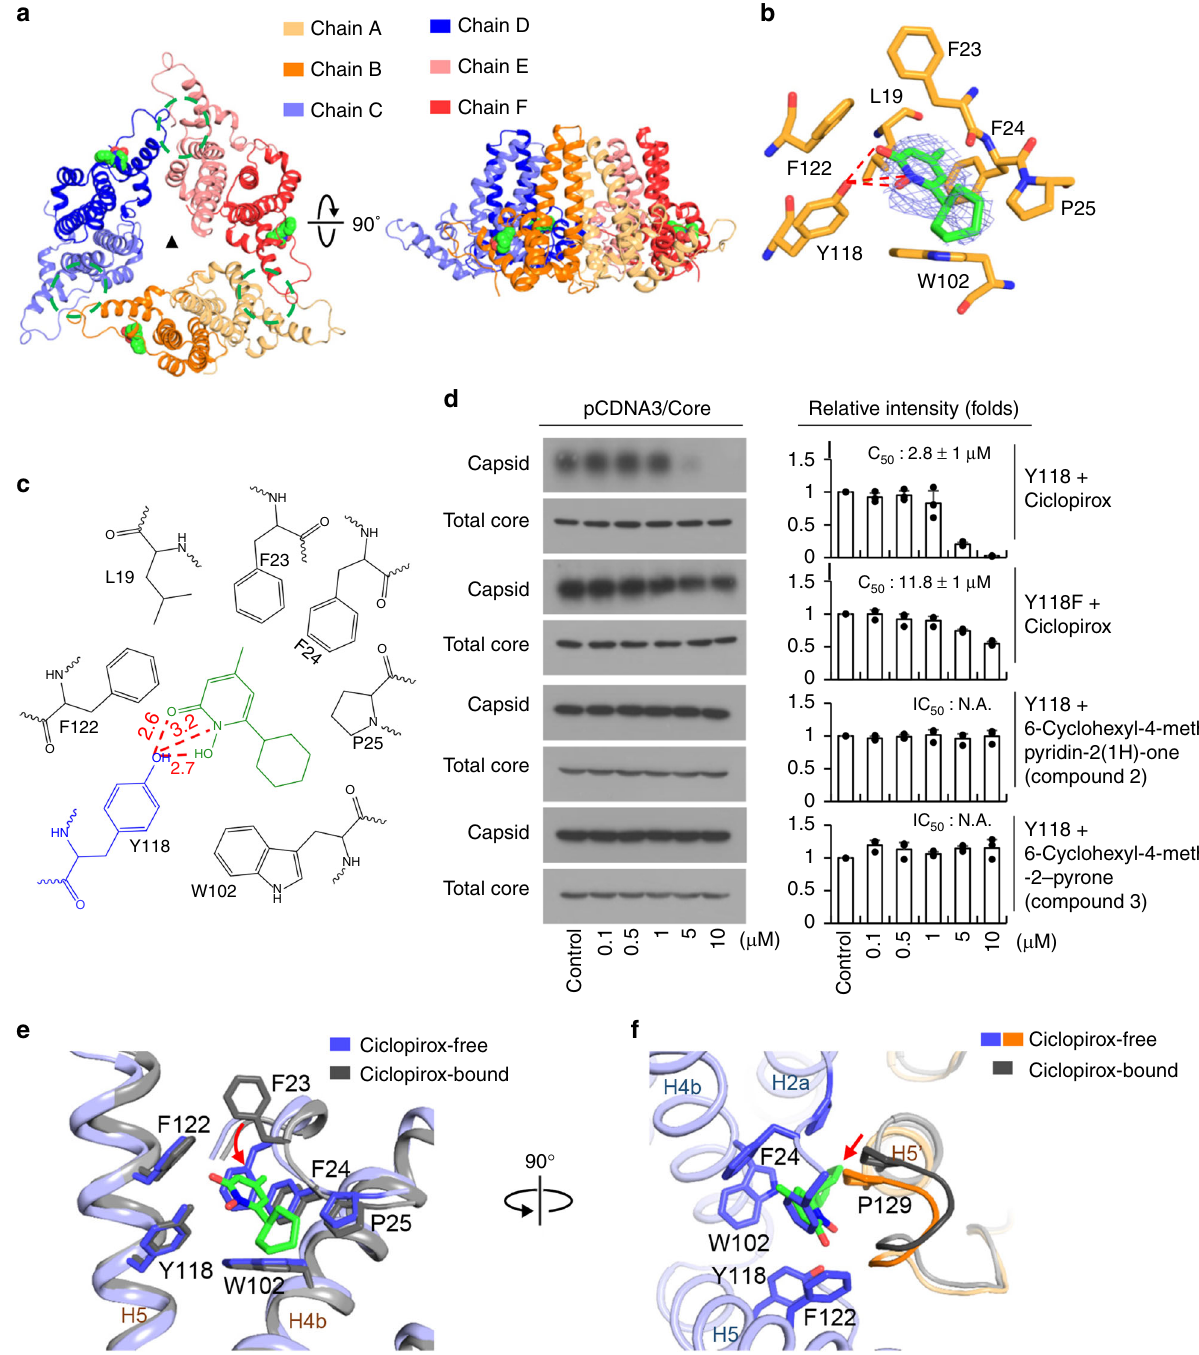
Fig. 3 Characterization of the ciclopirox binding sites on HBV core protein. a Overall architecture of the hexamer in the asymmetric unit. The six protomers are colored light orange, orange, light blue, blue, pink, and red. The secondary structure of the protein was calculated using STRIDE 62 . Ciclopirox is shown as a space- fi lling model. The binding sites at the dimer-dimer interfaces that are not bound by ciclopirox are highlighted by dashed green circles. The black triangle indicates the icosahedral threefold axis of the HBV capsid. Top view (left panel) and side view (right panel). b The ciclopirox binding site in chain B. The view is the same as in the right panel of a . The residues involved in ciclopirox binding are in orange. The simulated annealing omit map superimposed on the re fi ned ciclopirox model was contoured at the 2.5 σ level. c Schematic depiction of the HBV core protein-ciclopirox interaction. The residues involved in ciclopirox binding are shown. Y118 and ciclopirox are in blue and green, respectively. d Effect of mutation of Y118 to phenylalanine (Y118F) and chemical modi fi cations of ciclopirox on intracellular HBV capsid assembly. e Comparison of the ciclopirox-bound and -free sites of chains ( b , c ). The two binding sites are aligned and the residues involved in ciclopirox binding are represented as sticks. The leucine at 19 is omitted for clarity. The view is the same as in b . The rotation of F23 is marked by the red arrow. f Movement of the proline-rich loop 6. The ciclopirox-free pocket is shown, and ciclopirox and loop 6 of the ciclopirox-bound protomer are superimposed on it. The movement of loop 6 is shown by the red arrow. This view is rotated by 90 degrees along the vertical axis from ( e ). The data in d are representative of three independent experiments and are expressed as mean ± SD. The error bars represent the ± SD. N.A., not available. * p < 0.05; ** p < 0.01, as determined by unpaired two-tailed Student ’ s t -tests. Source data are provided as a Source Data fi